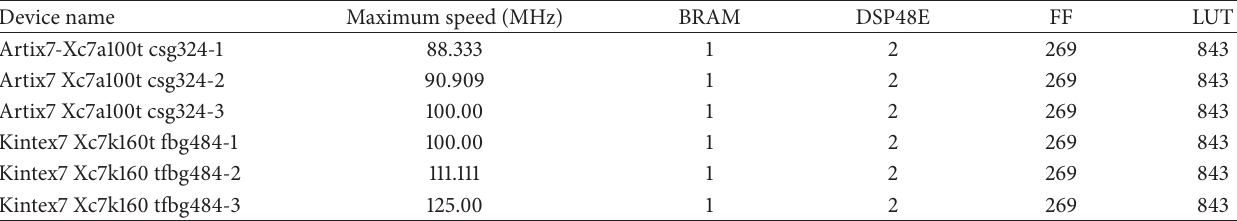
Table 2: Device utilization and maximum operating speed.